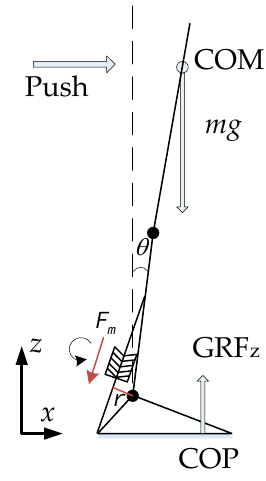
Figure 1. Schematic of upright standing push-recovery. m is the mass of the body (excluding the foot part); θ is the ankle joint angle; the clockwise direction is defined as positive; CoP is the point of center of pressure; GRFz is the z-axis ground reaction force; F m is the calf muscle force.